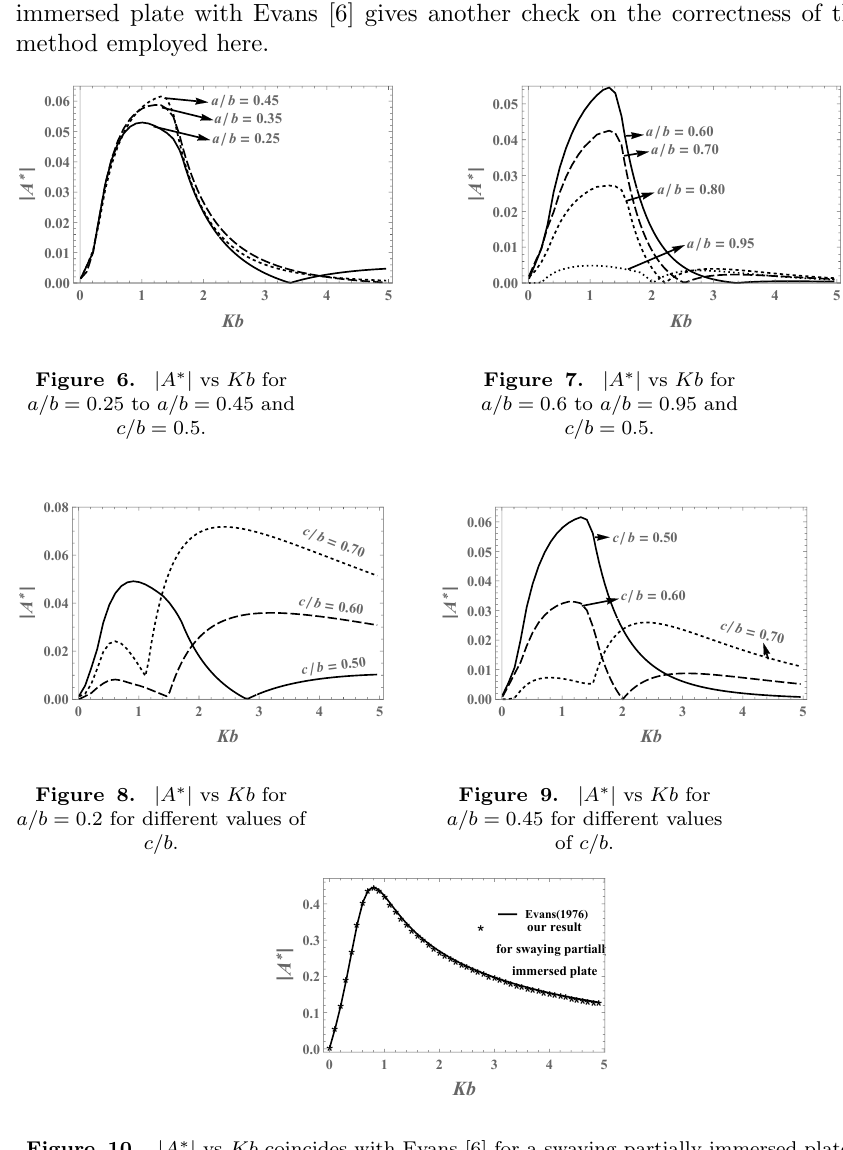
Figure 10. | A ∗ | vs Kb coincides with Evans [6] for a swaying partially immersed plate. The amplitude of a swaying submerged plate can similarly be observed